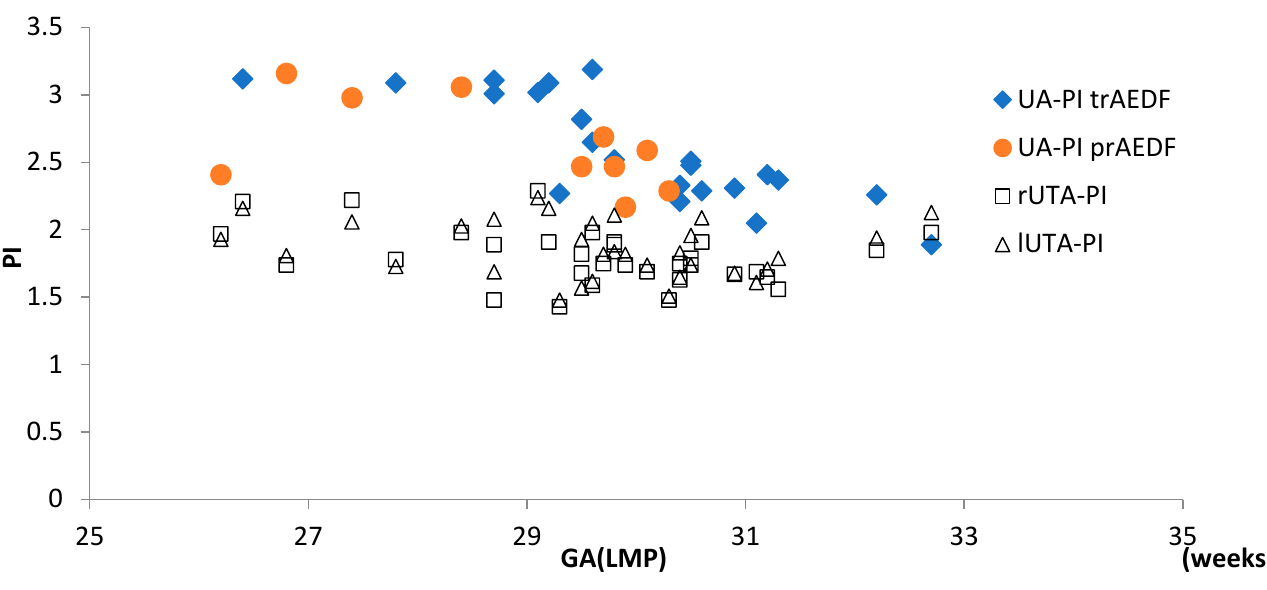
(tr/prAEDF groups) (Figure 5).